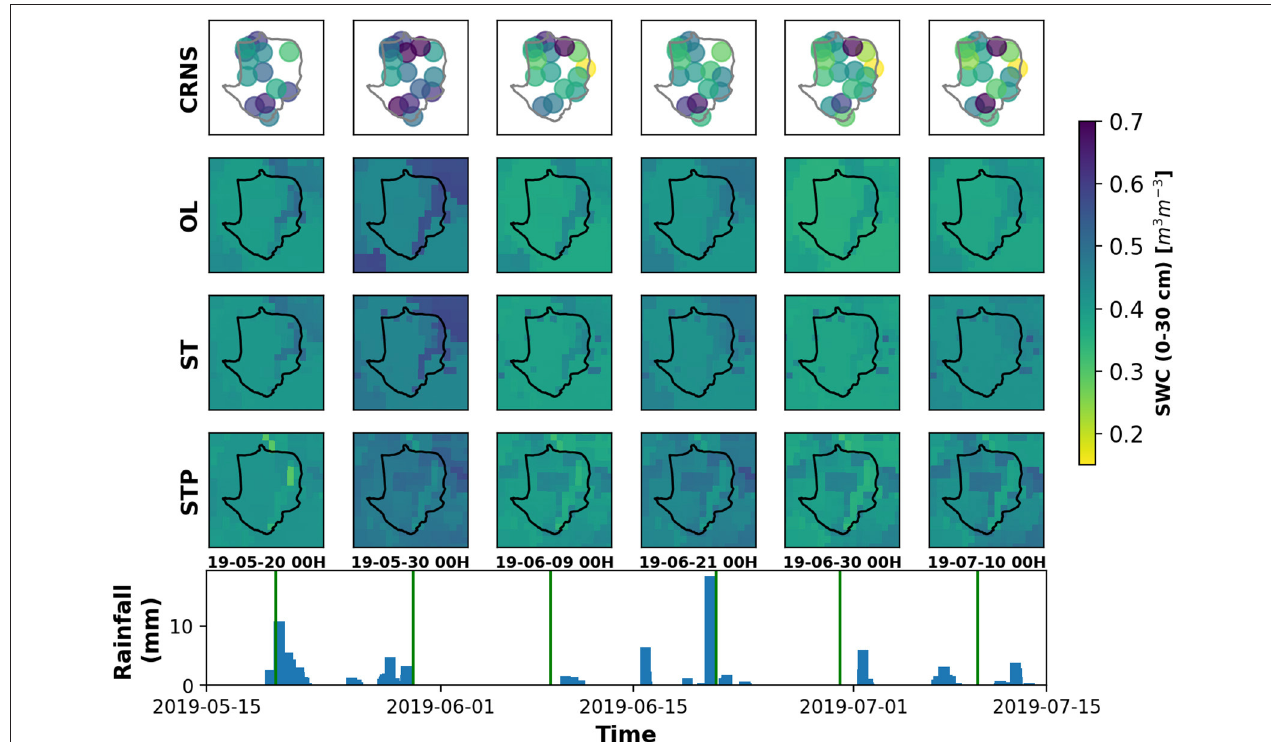
FIGURE 5 | Rainfall and spatial distribution of field scale soil moisture on 20 May 19, 30 May 19, 9 June 19, 21 June 19, 30 June 19, and 10 July 19 at the Fendt study site from dense CRNS sensor network ( Fersch et al., 2020a) and its comparison with simulated root zone soil moisture (0–60 cm) from OL, ST, and STP model runs for the evaluation period. The black line in the spatial soil moisture plots shows the boundary of the field campaign site and the vertical lines on the rainfall time series represent the selected time steps for the spatial plots.